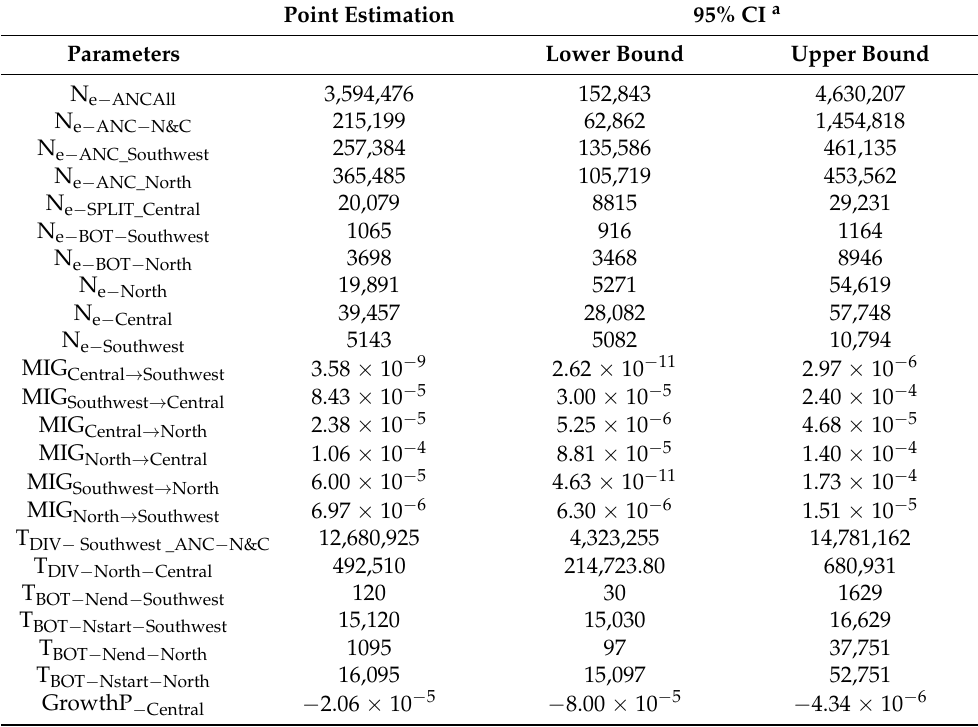
Table 1. Demographic parameter estimates of the best model in Figure